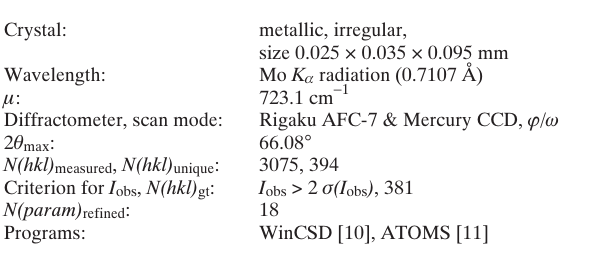
Table 1. Data collection and